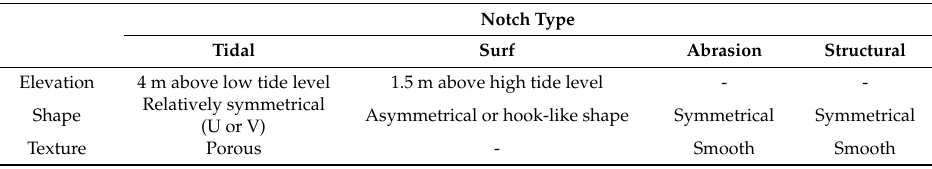
Table 1. Notch genesis classification criteria [6].